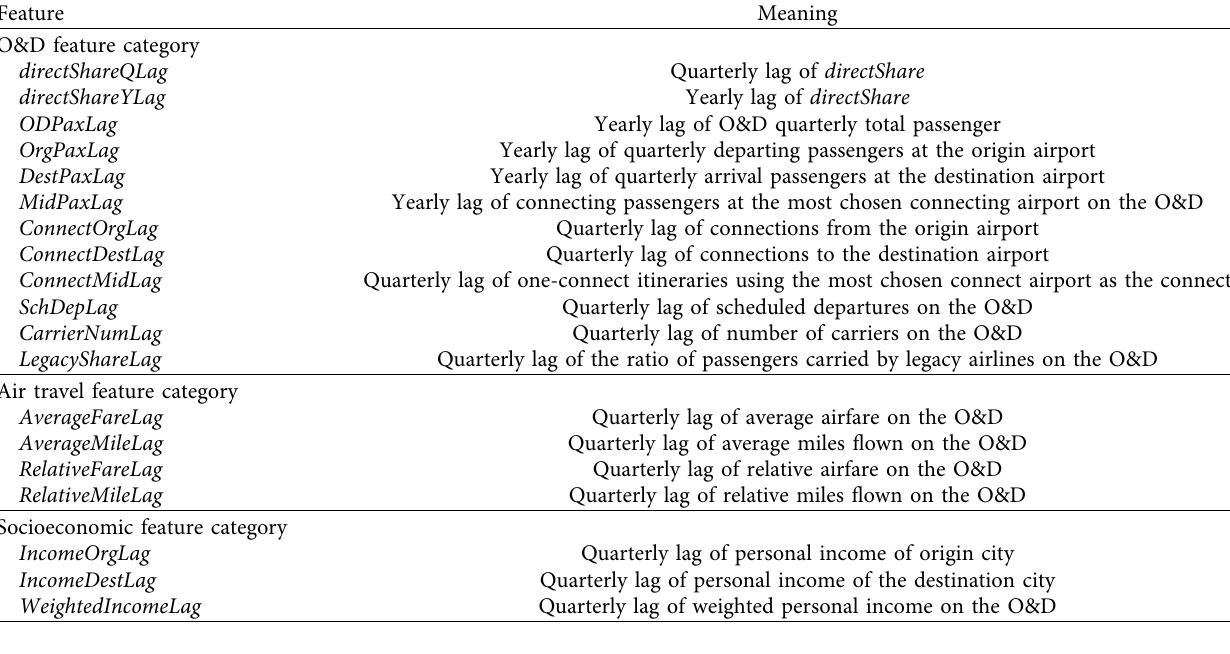
Table 1: Feature category and